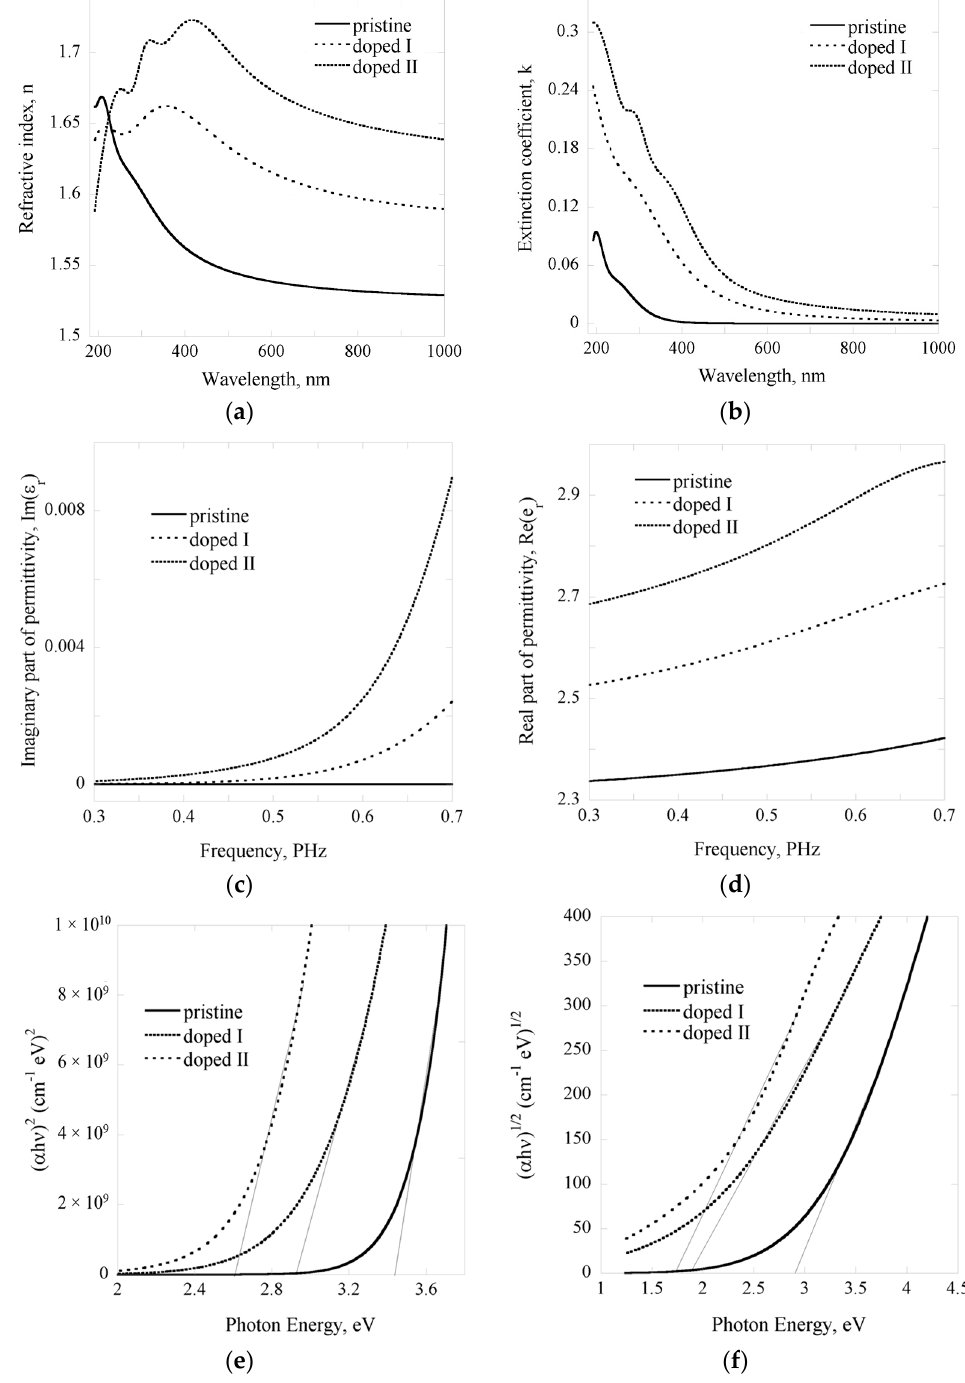
Figure 2. Optical properties of pristine and iodine-doped polyterpenol samples obtained using ellipsometry: ( a ) refractive index; ( b ) extinction coefficient; ( c ) real and ( d ) imaginary parts of permittivity as a function of frequency; ( e ) direct and ( f ) indirect allowed transition energies of pristine and iodine-doped polyterpenol films.